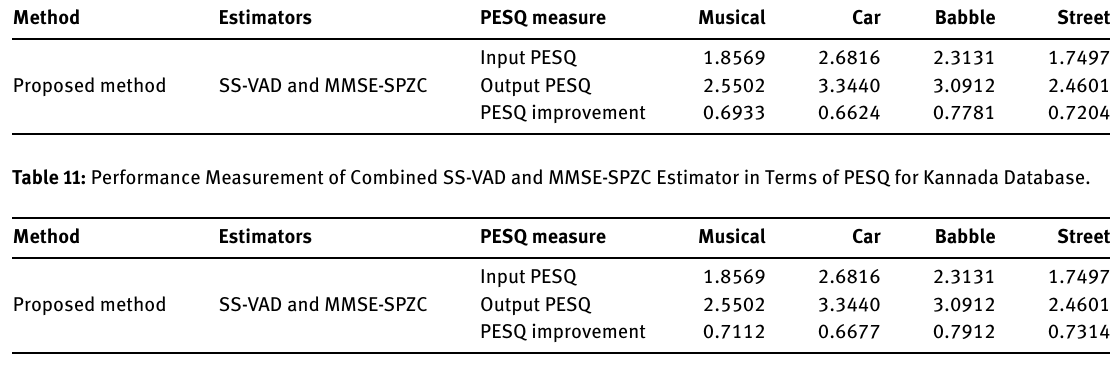
Table 12: Performance Evaluation of Combined SS-VAD and MMSE-SPZC Method Using Composite Measure for TIMIT Database. Method